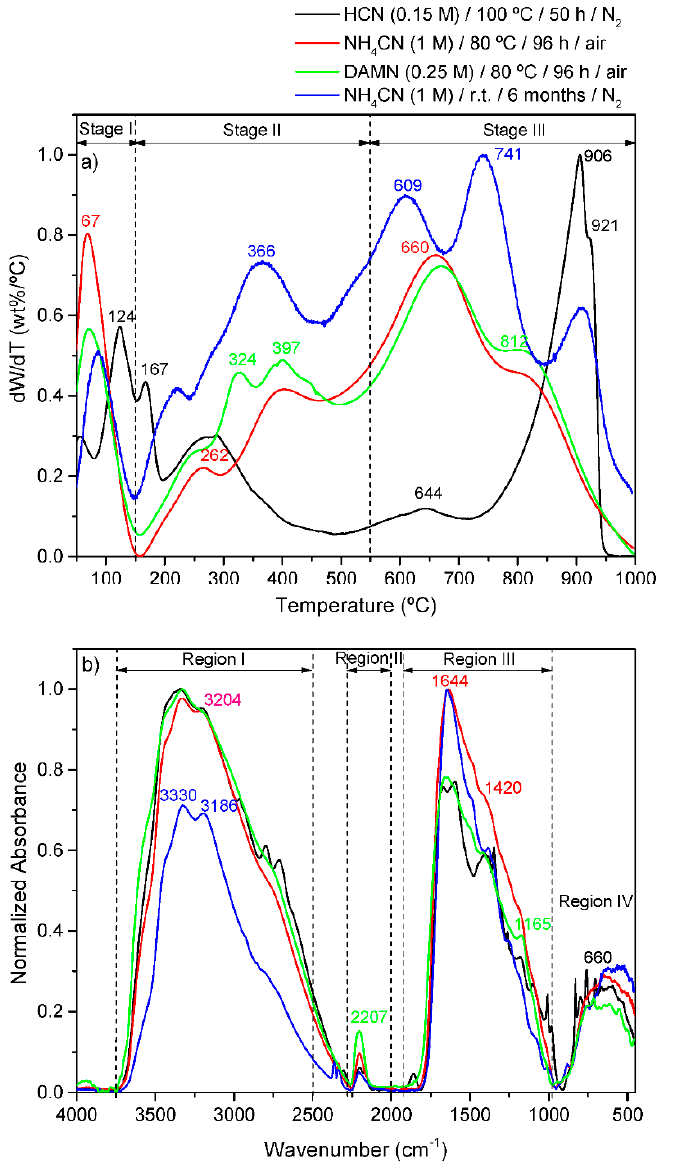
Figure 5. HCN-derived polymers synthesized under different experimental conditions: ( a ) differential thermogravimetry (DTG) curves; ( b ) Fourier transform infrared (FT-IR) spectra.